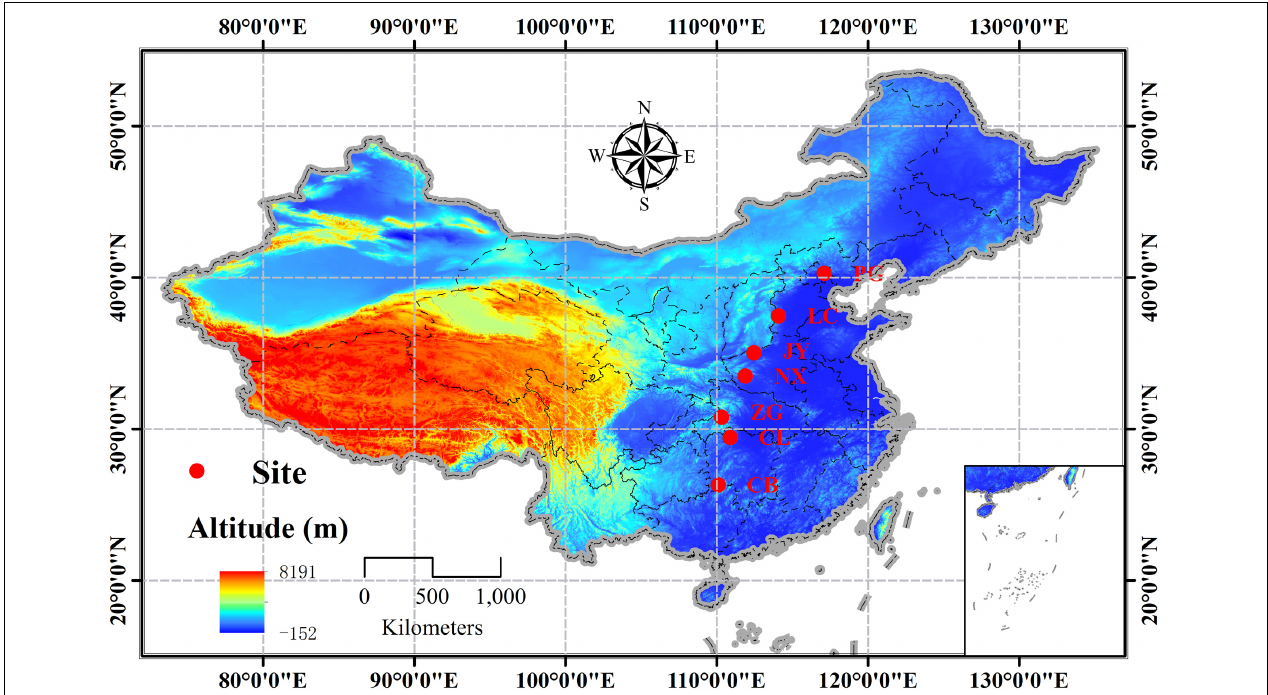
FIGURE 1 | Distribution of the sampling sites of Quercus variabilis in China (PG: Pinggu, Beijing; LC: Lincheng, Hebei; JY: Jiyuan, Henan; NX: Neixiang, Henan; ZG: Zigui, Hubei; CL: Cili, Hunan; and CB: Chengbu,